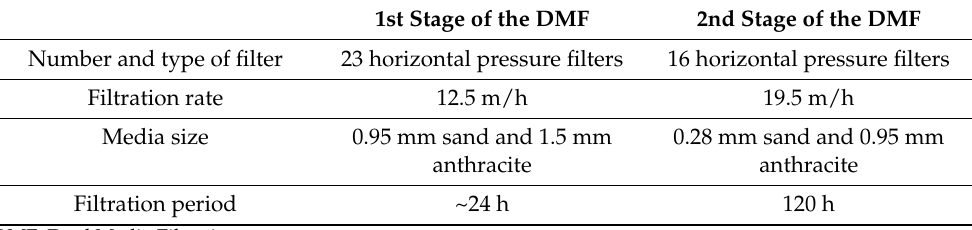
Table 1. Characteristics and operational properties of the two-stage media